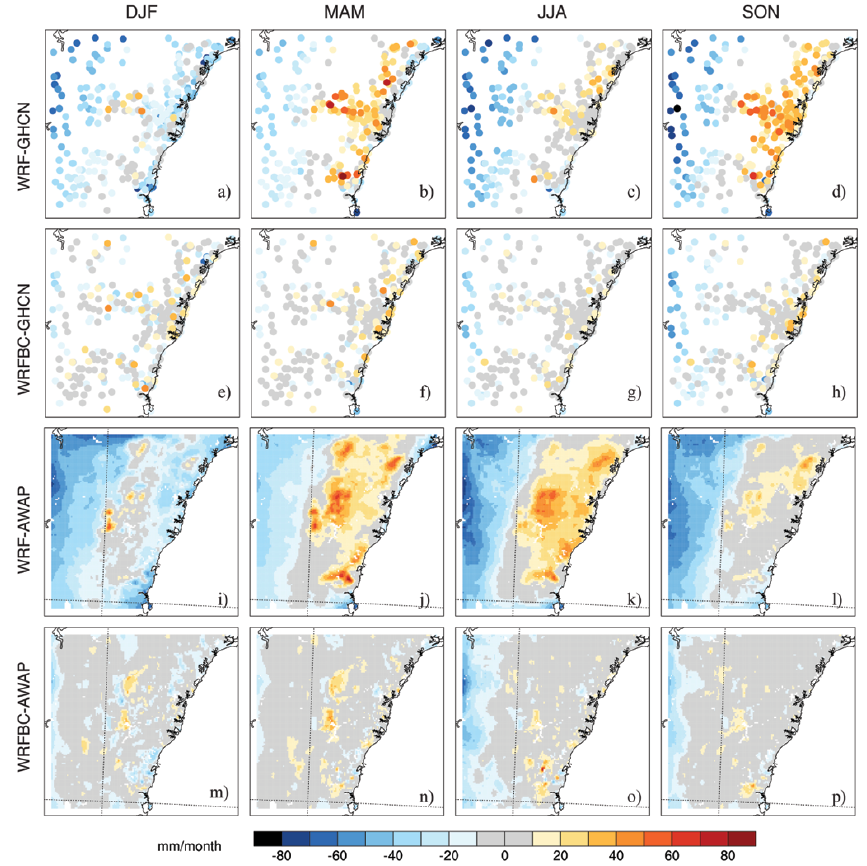
Fig. 6. Precipitation seasonal biases of non-corrected WRF with respect to the stations (a – d) , bias-corrected WRF with respect to the stations (e – h) , non-corrected WRF with respect to AWAP (i – l) and bias-corrected WRF with respect to AWAP (m – p) over the period